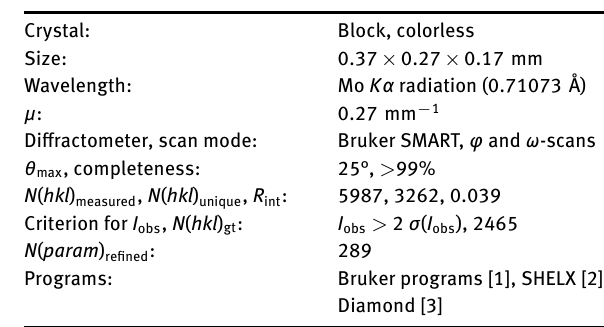
Table 1: Data collection and handling.